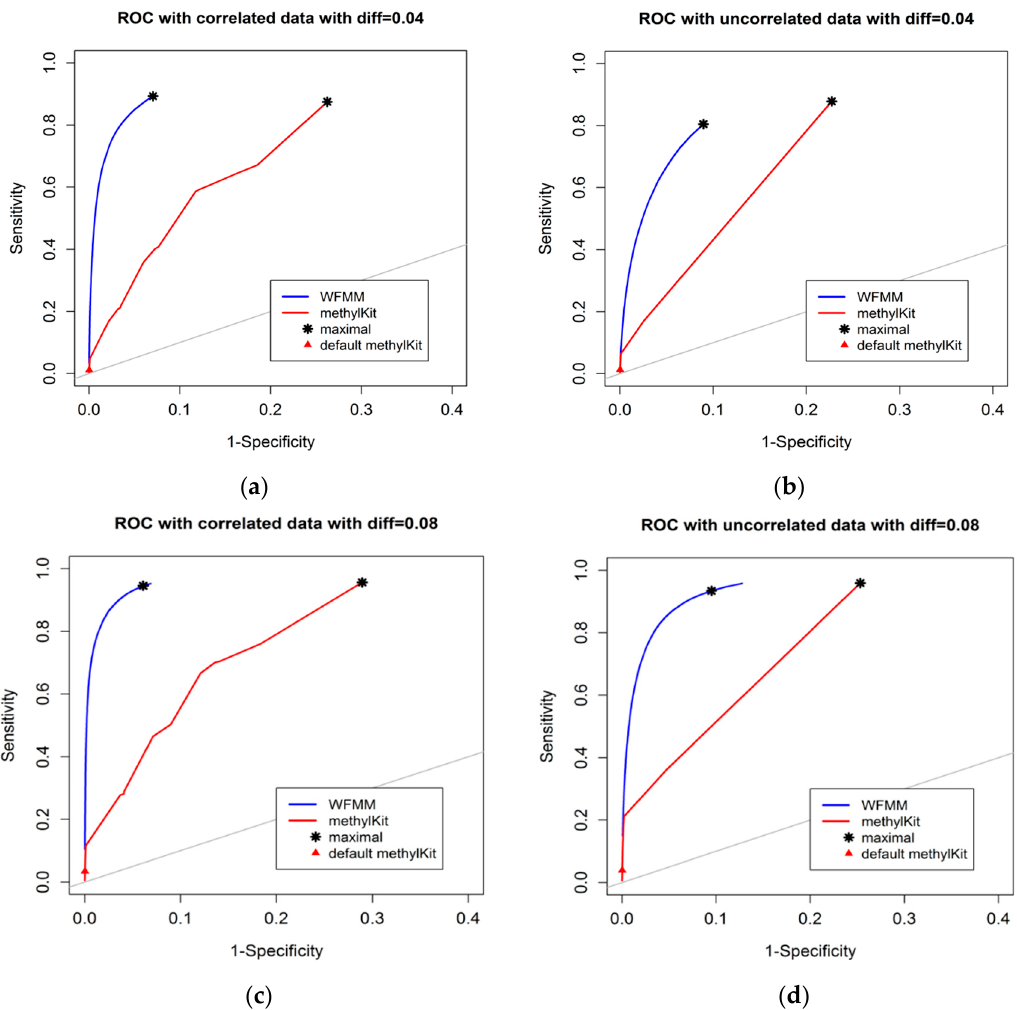
Figure 2. Receiver operating characteristic (ROC) curve comparison between wavelet-based functional mixed model (WFMM) (blue curve) and methylKit (red curve) when the differentially methylated cutoff is 0.04 in correlated cytosines ( a ) and uncorrelated cytosines ( b ) and when the differentially methylated cutoff is 0.08 in correlated cytosines ( c ) and uncorrelated cytosines ( d ). The gray line represents points where sensitivity equals specificity.